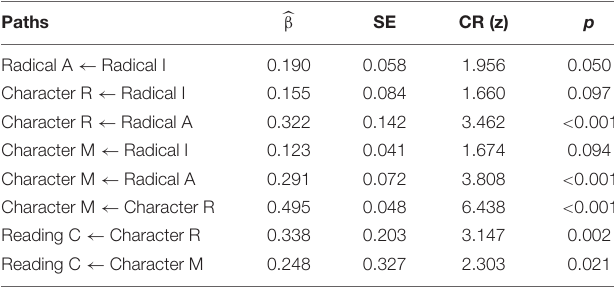
TABLE 4 | Standardized regression weights for all measures based on conceptual model 3.